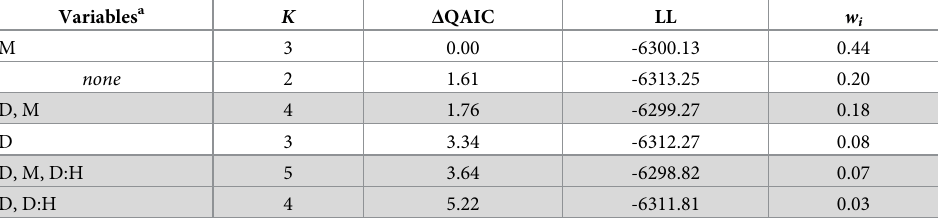
Table 8. Variables, number of parameters ( K ), delta Quasi-AIC ( Δ QAIC), log-likelihood (LL), and QAIC weights ( w i ) for bats-only top model set. Because Δ QAIC was less than six for all models, the top model set is the same as the full model set. Shaded rows represent models with uninformative parameters.